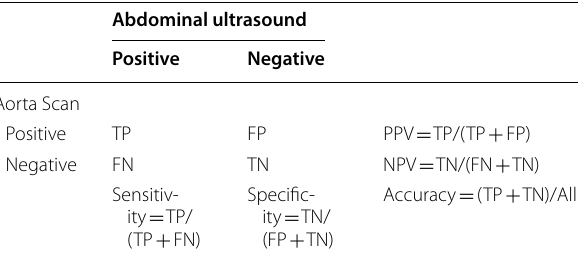
Table 2 Methods to calculate sensitivity, specificity, PPV, NPV and